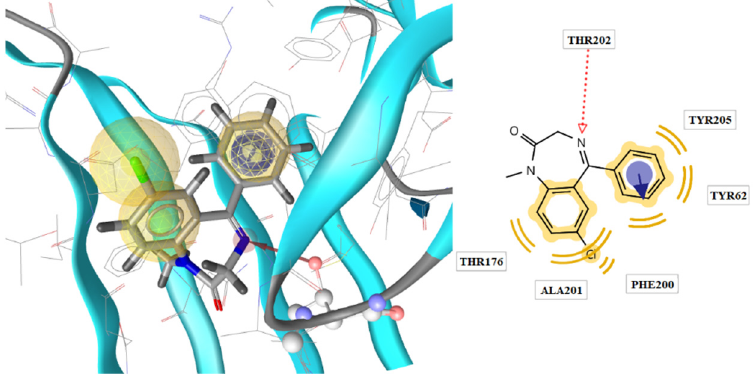
Figure 5. Docked conformation of diazepam and GABA A receptor complex.